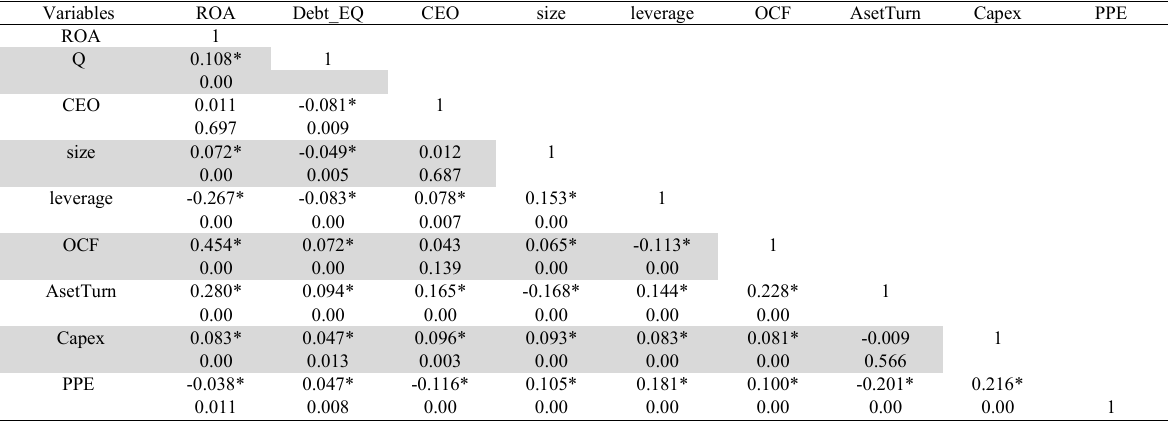
Pairwise correlations